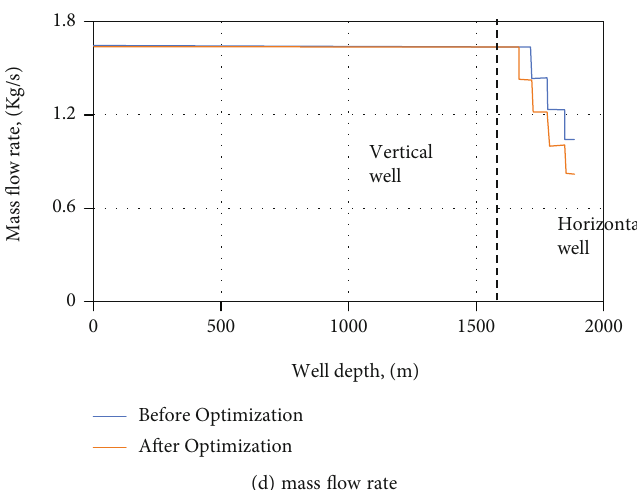
Figure 16: The (a) steam pressure, (b) steam temperature, (c) steam quality and (d) mass fl ow rate of steam along the wellbore of Well XH27 with optimized injection